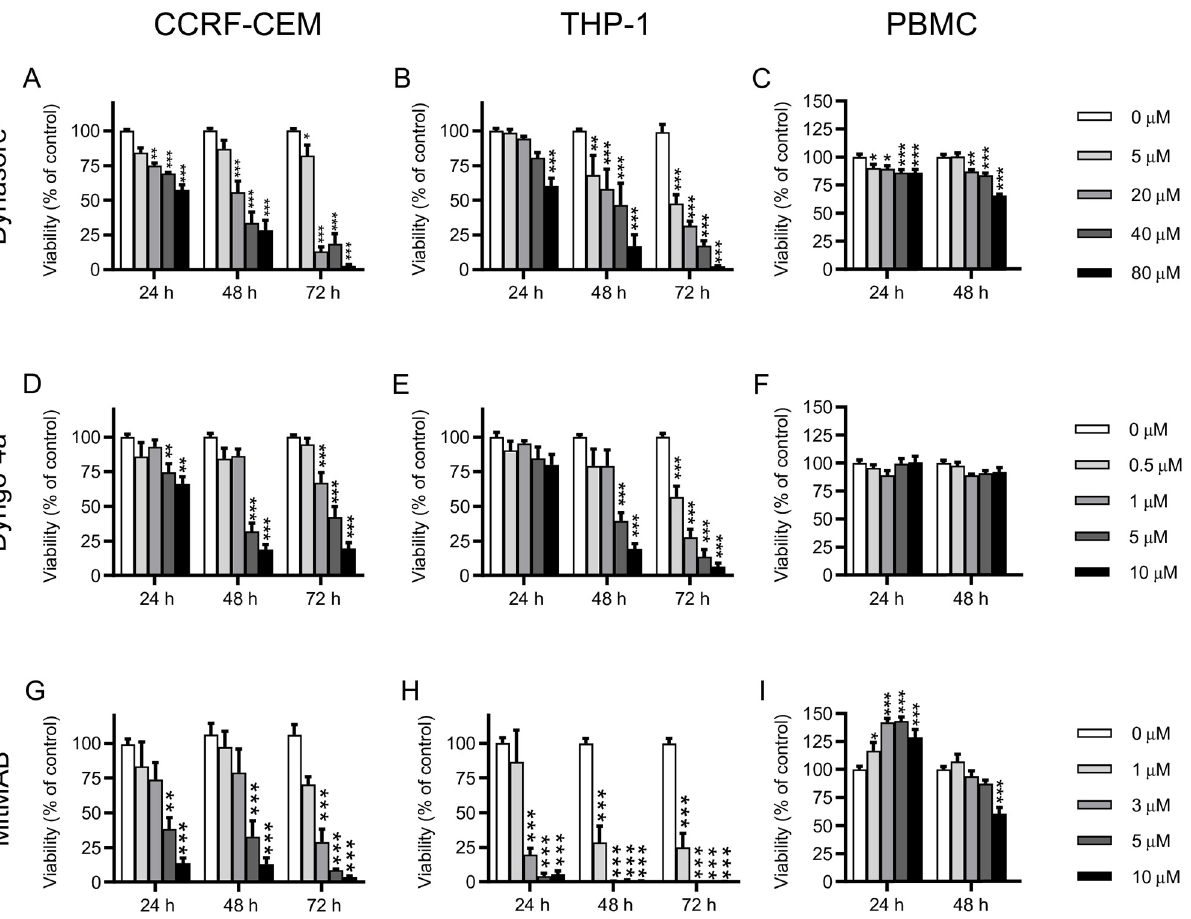
Fig 1. Dynamin inhibitors decrease the viability of acute leukemia cells. CCRF-CEM (A, D, G;), THP-1 (B, E, H) or human PBMCs (C, F, I) (0.15 x 10 6 cells/ml) were cultured for the time points indicated with the given concentrations of Dynasore (A-C), Dyngo-4a (D-F) or MitMAB (G-I). Viability was assessed with PrestoBlue and was normalized to untreated control (0 μ M) groups. Data are given as mean + SEM pooled from 5–9 biological replicates. Two-way ANOVA was used for statistical testing with Dunnett’s posthoc test in order to compare each treated group with the control at each time